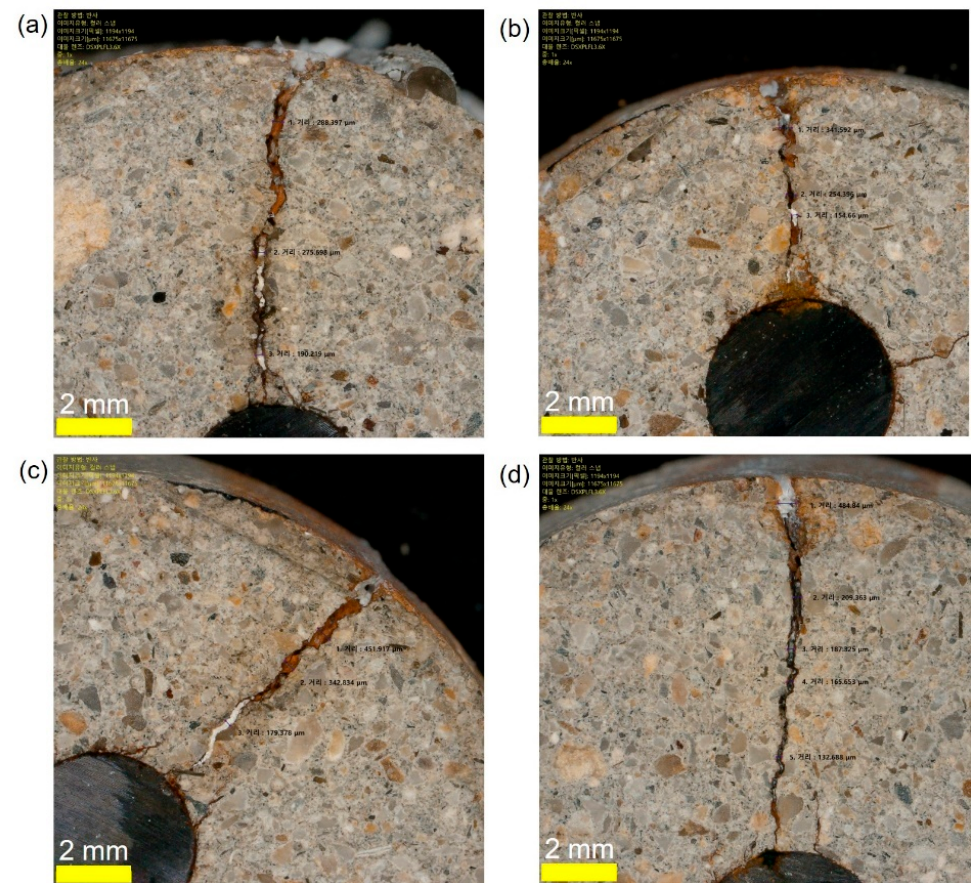
Figure 12. Optical microscopic images of the cross-sections of concrete samples: ( a ) TP3-1, ( b ) TP3-2, ( c ) TP3-3, and ( d ) TP3-4, respectively, after being rehabilitated by EDT with various configuration of pre and post treatment of EDT processes.